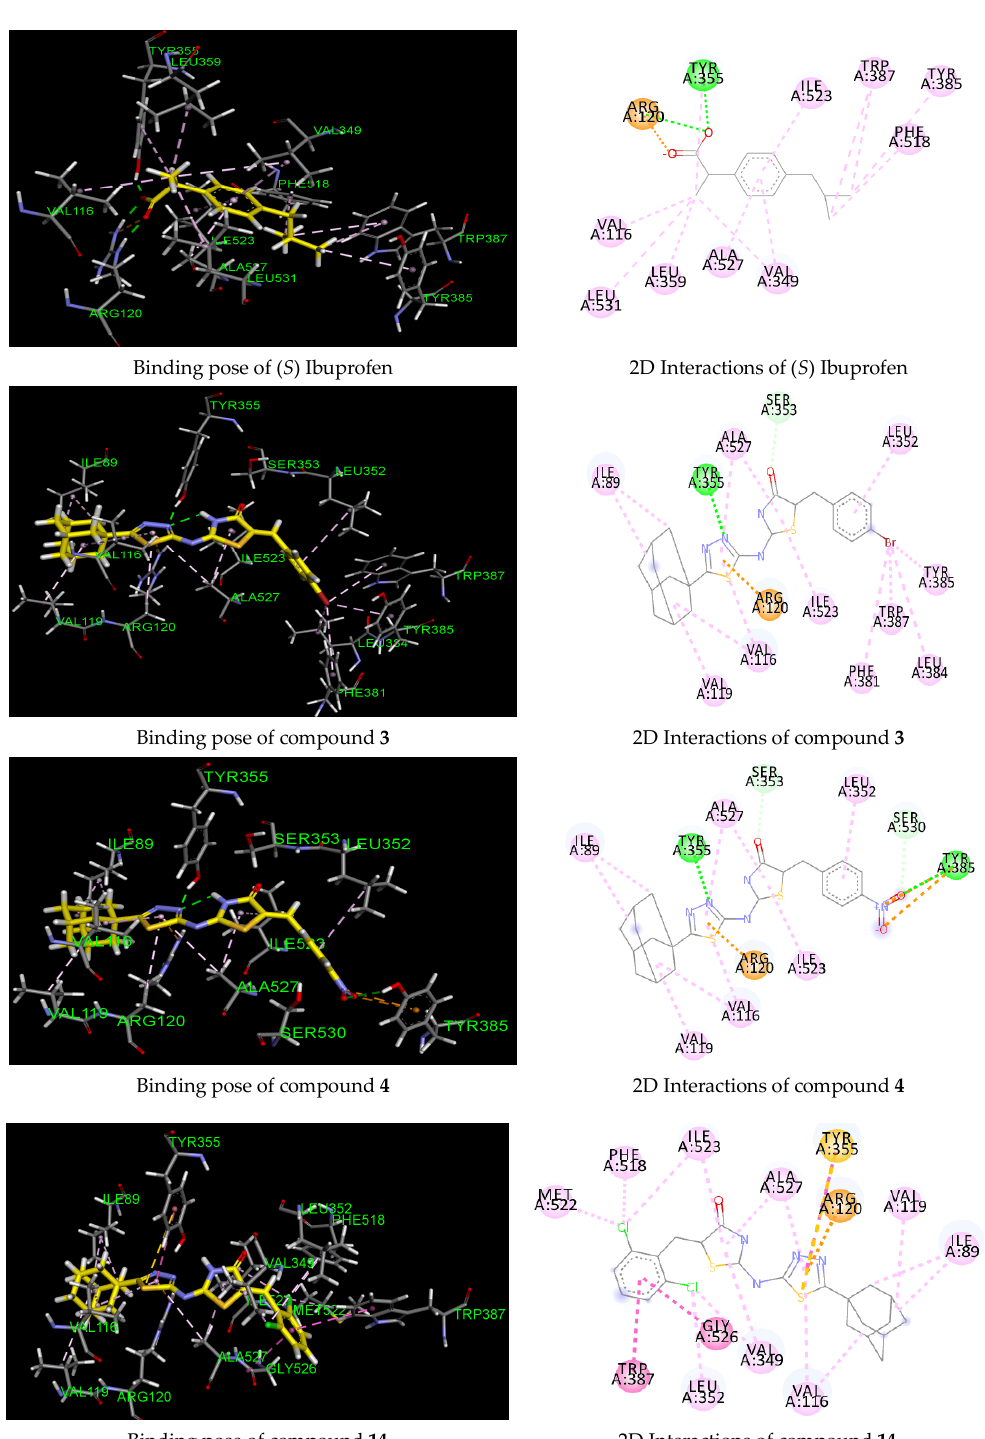
Figure 3. Three- and two-dimensional representations of the binding mode of ibuprofen and com- pounds 3 , 4 and 14 in COX-1 active site (PDB 1EQG). H-bond, halogen, pi–pi, pi–alkyl and pi-cation interactions are represented as dotted lines in green, blue, violet, grey and orange, respectively.